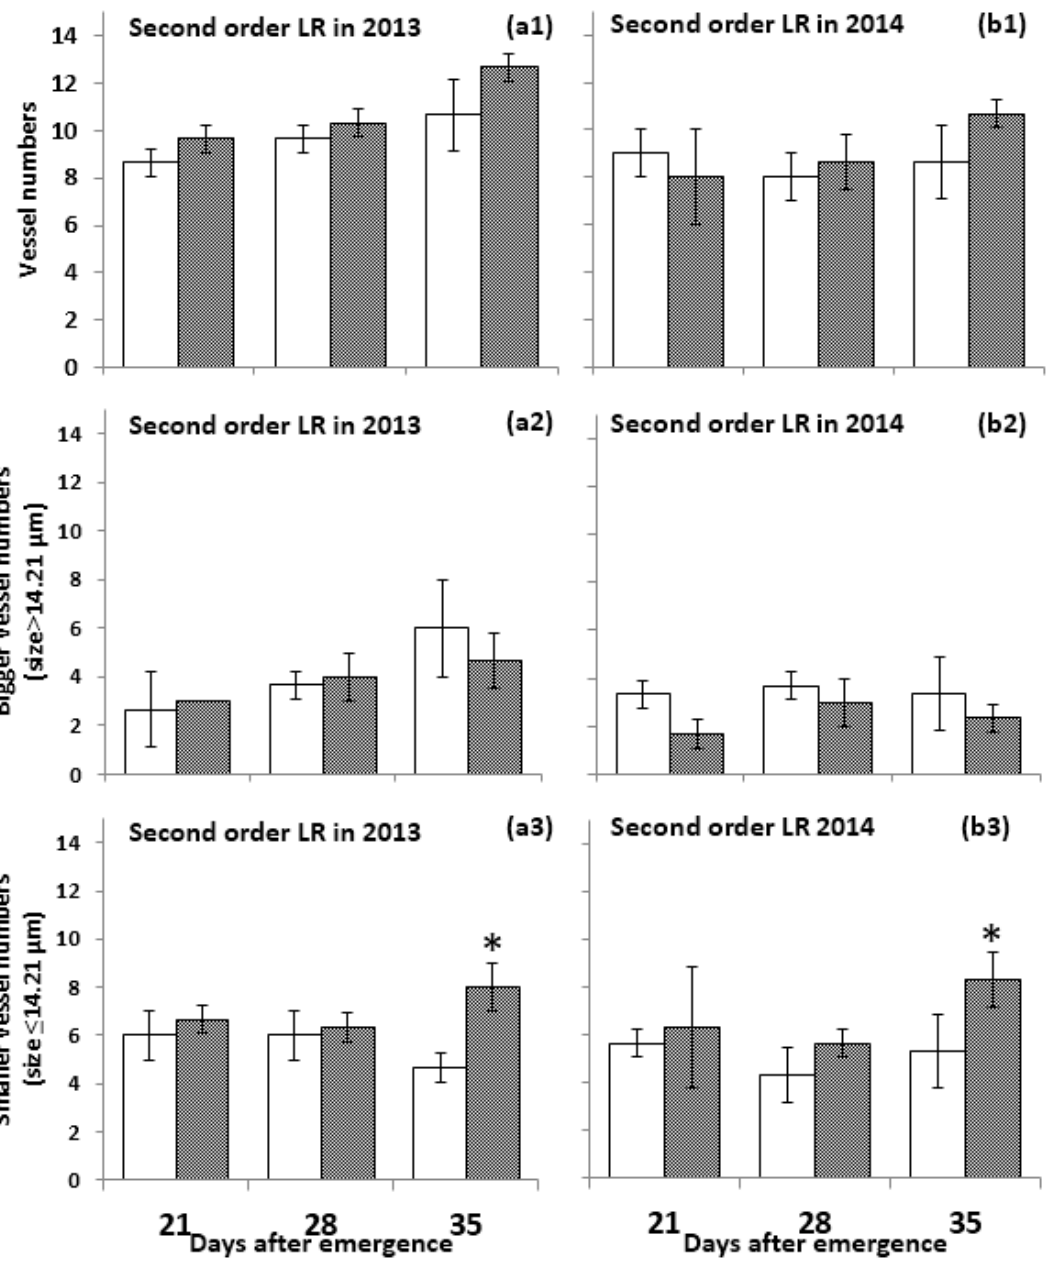
Figure 9. Vessel numbers of second order lateral roots ( a1 , b1 ), bigger vessel number ( a2 , b2 ) and smaller vessel number ( a3 , b3 ) of peanut at 21, 28 and 35 DAE in 2013 ( a ) and in 2014 ( b ); Significant at * p ≤ 0.05, non-stress treatments ( □ ) and stress treatments ( ■ ).